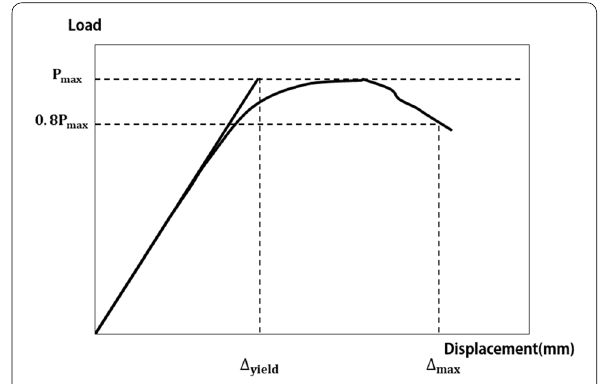
Fig. 12 Displacement ductility.